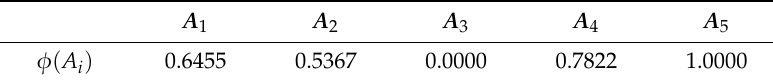
Table 20. Value of φ ( A i , A k )